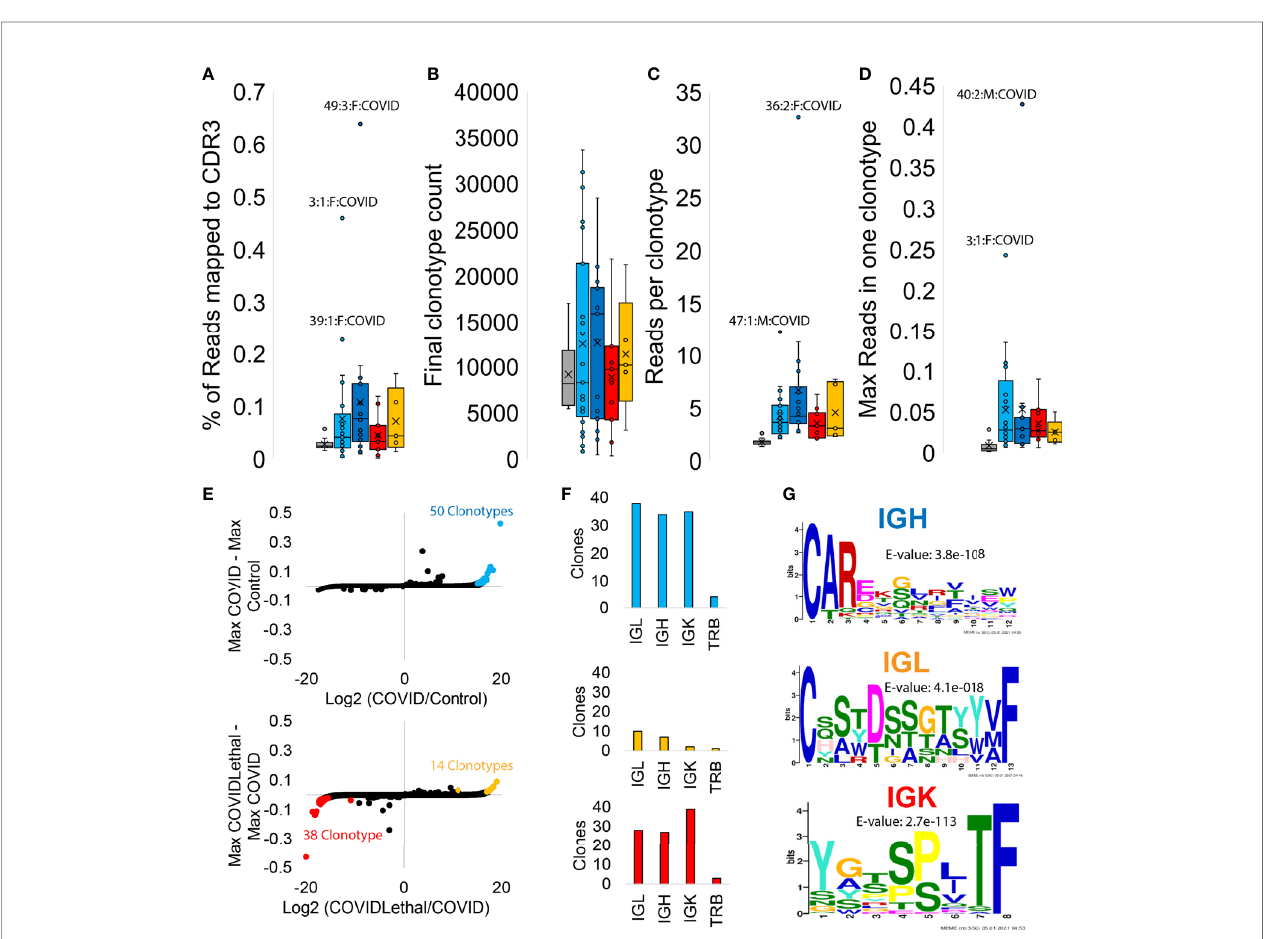
FIGURE 7 | Blood transcriptome immune repertoire signatures of SARS-CoV-2 patients. (A – D) Box and whisker plots for statistics for MiXCR CDR3 analysis. Samples are grouped as controls (gray), COVID fi rst collection (cyan), COVID later collections (blue), COVID/Lethal fi rst collection (red), or COVID/Lethal later collections (orange). Data is shown for the % of reads mapped to CDR3 from all reads (A) , the number of clonotypes per sample (B) , the number of reads per clonotype per patient (C) , and the max number of reads within one of the clonotypes for each patient (D) . (E) The log2 fold change (x-axis) of group averages relative to the max values (y-axis) for each clonotype in all COVID samples vs. Controls (top) or Lethal COVID vs. non-Lethal COVID (bottom). Outlier clonotypes enriched in one of the groups are labeled (cyan, red, orange). (F) Clones labeled in panel E (cyan, red, orange) analyzed through CDR3 types (IGL, IGH, IGK, TRB). (G) Meme motifs for labeled CDR3 types of extracted clones. Color of IGH/IGL/IGK corresponds to the clones extracted from the colored outliers of panel E